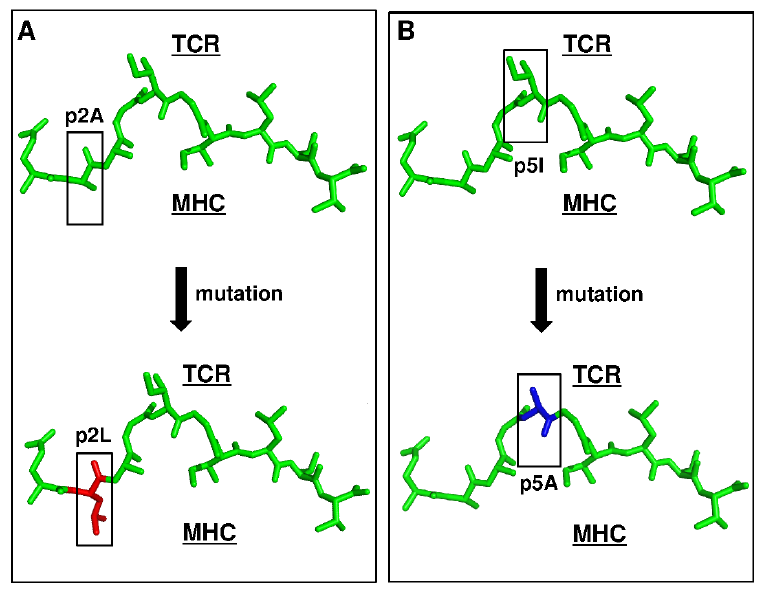
Figure 3. Neoantigens as targets for T cells: possible effects of single mutations. ( A ) A mutation in a major histocompatibility complex (MHC) anchor residue (Ala to Leu; shown in red) is shown. Such a mutation could improve the binding of the peptide to MHC and thereby increase the number of peptide-MHC (pepMHC) complexes on a target cell (antigen-presenting cell). ( B ) A mutation (Ile to Ala; shown in blue) in a residue that points away from the MHC but is in a position to interact with a T-cell receptor (TCR) is shown. Since the normal repertoire of peripheral T cells has not been tolerized against the mutated peptide, there are likely to be some TCRs that have binding affinities for this pepMHC complex that drive T-cell activity. Alternatively, a combination of effects shown in ( A ) and ( B ) might be achieved when the mutated residue impacts affinity for the MHC but also alters the conformation of the exposed peptide which could interact with a TCR. For reference, the MART-1 peptide is shown (PDB: 4QOK) and the specific mutations were either present in a known structure (PDB: 3HG1) or modeled by using